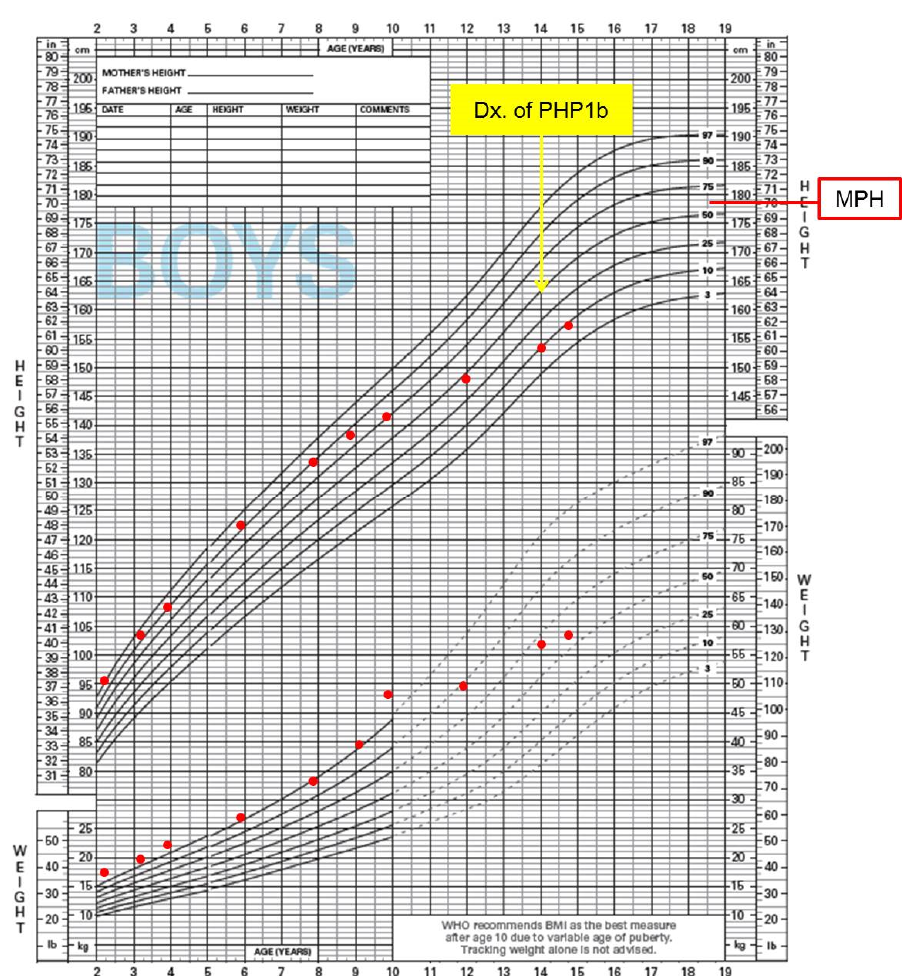
Figure 1. Patient growth curve. In his growth curve, the height velocity had been maintained above 90th percentile until about 8 years old, however the height velocity had slowed down after 9–10 years old and locates below the range of genetic target height (MPH) at 14 years of age.